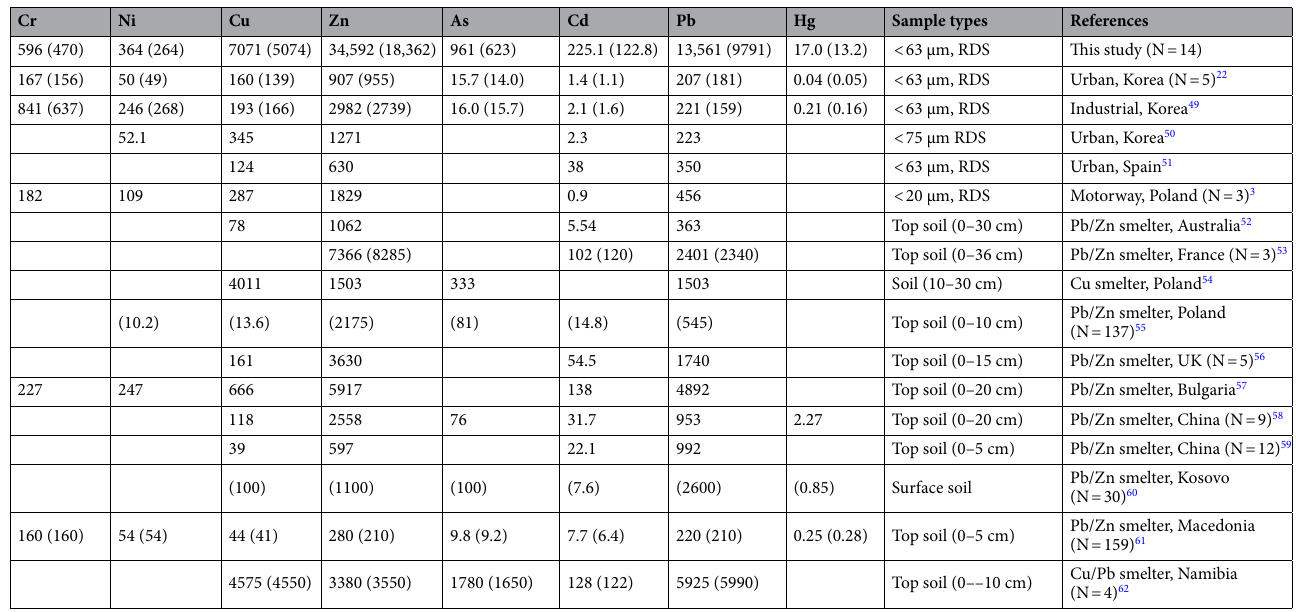
Table 2. Comparison between the average (median value in parenthesis) PTEs concentrations (mg/kg) in the road deposited sediment (< 63 μm) and those in the other published